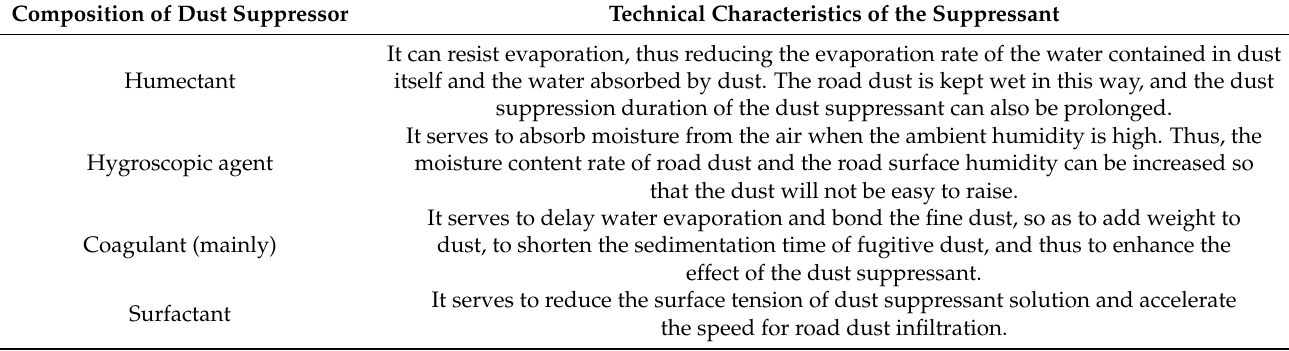
Table 2. The technical characteristics of the